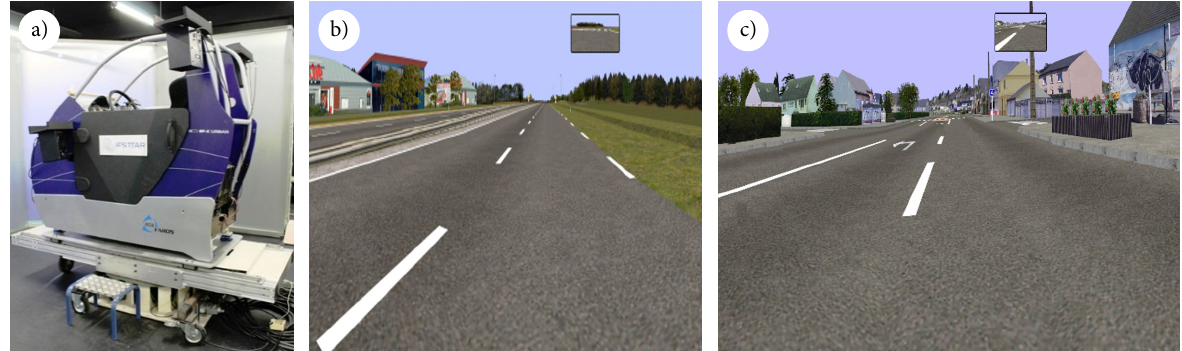
Fig. 4. Two DoF driving simulator (a), virtual environment